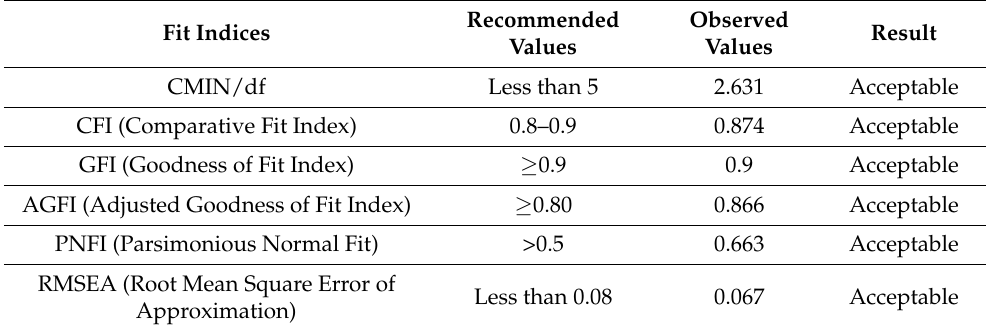
Table 5. Model Fit Indices (Confirmatory Factor Analysis).